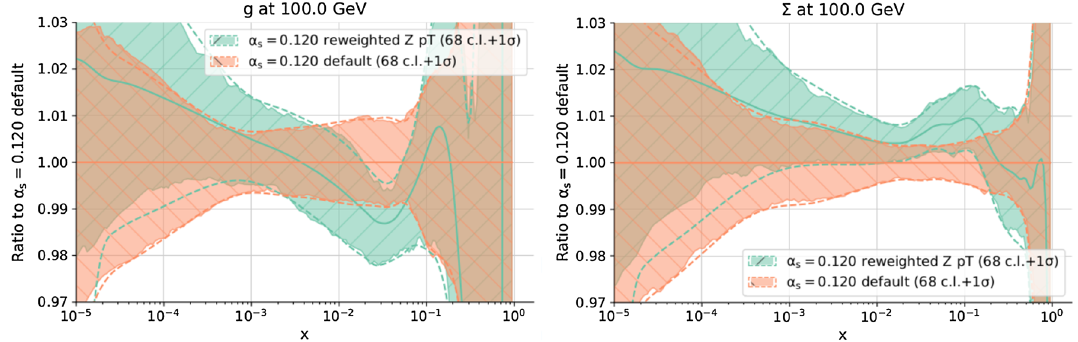
Fig. 2 The probability distributions for the best-fit values α ( k ) s Eq. (3) and α r s ( k ) distribution (right). Each marker indicates the value corresponding to each individual parabola of Fig. 1